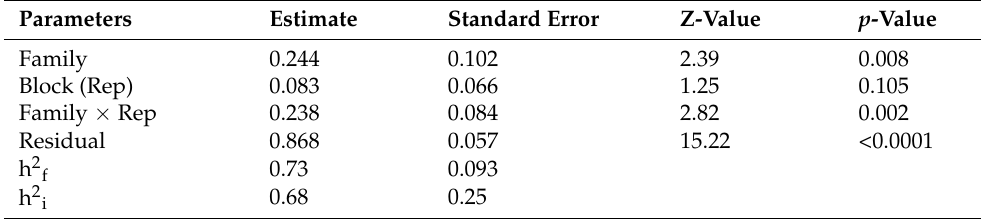
Table 1. Genetic variation in rust incidence in a Summer × Kanlow switchgrass population evaluated in the second and third generations in the field, near Mead, NE, in 2021.